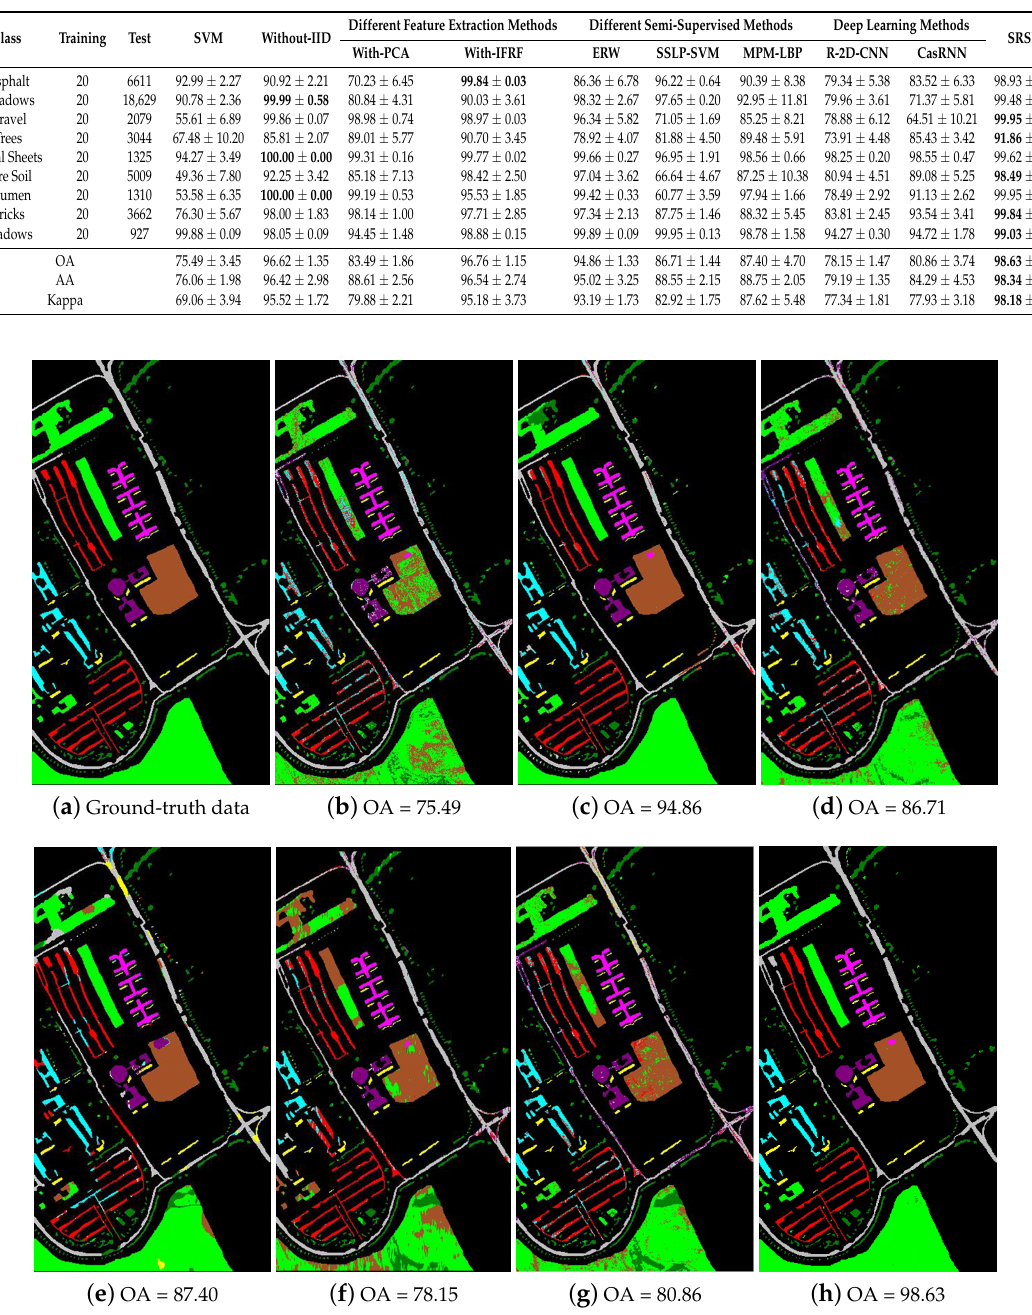
Table 2. Classification accuracies (University of Pavia) in percentages for the tested methods when 20 training samples per class are provided. (The bold values indicate the greatest accuracy among the methods in each case.)